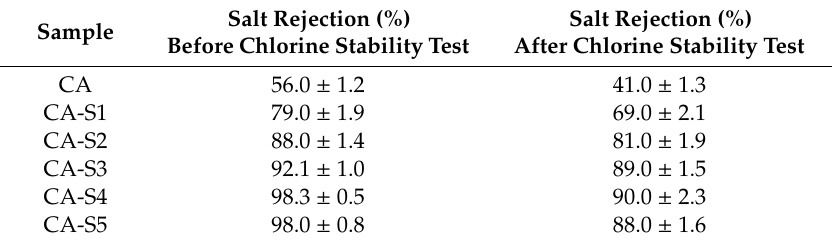
Figure 4. Salt rejection (%) through an NF-TFC membrane before and after chlorination. Table 2. Salt rejection (%) through an NF-TFC membrane before and after chlorination.